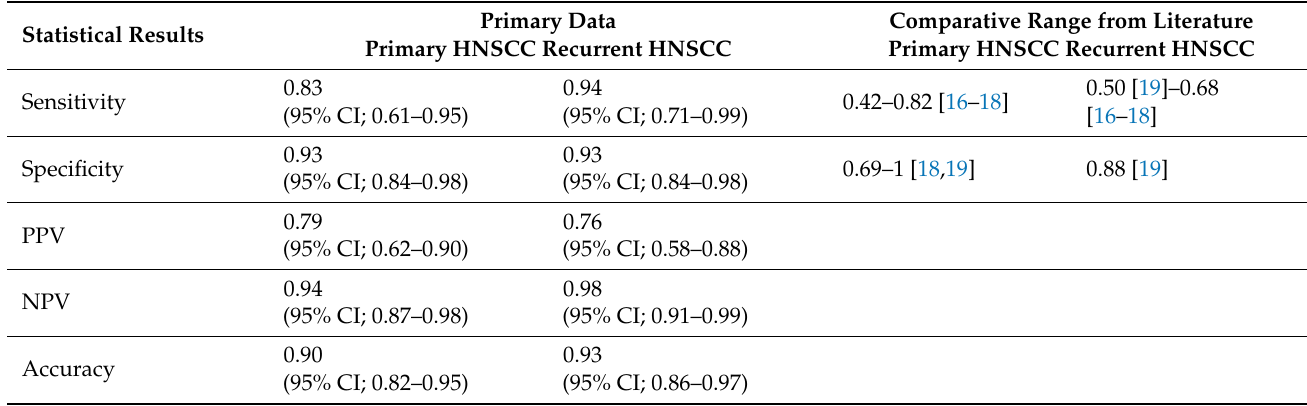
Table 4. Detectability of primary and recurrent Head and Neck Squamous Cell Carcinoma (HNSCC) with state-of-the-art CT technology in comparison to ranges of standard CT values from literature.